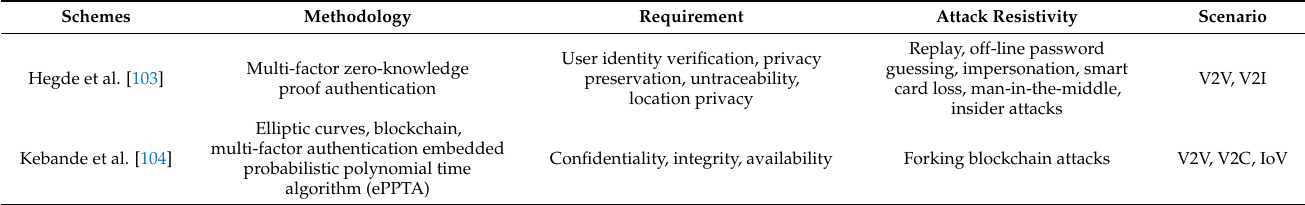
Table 10. Classification of multi-factor authentication schemes.